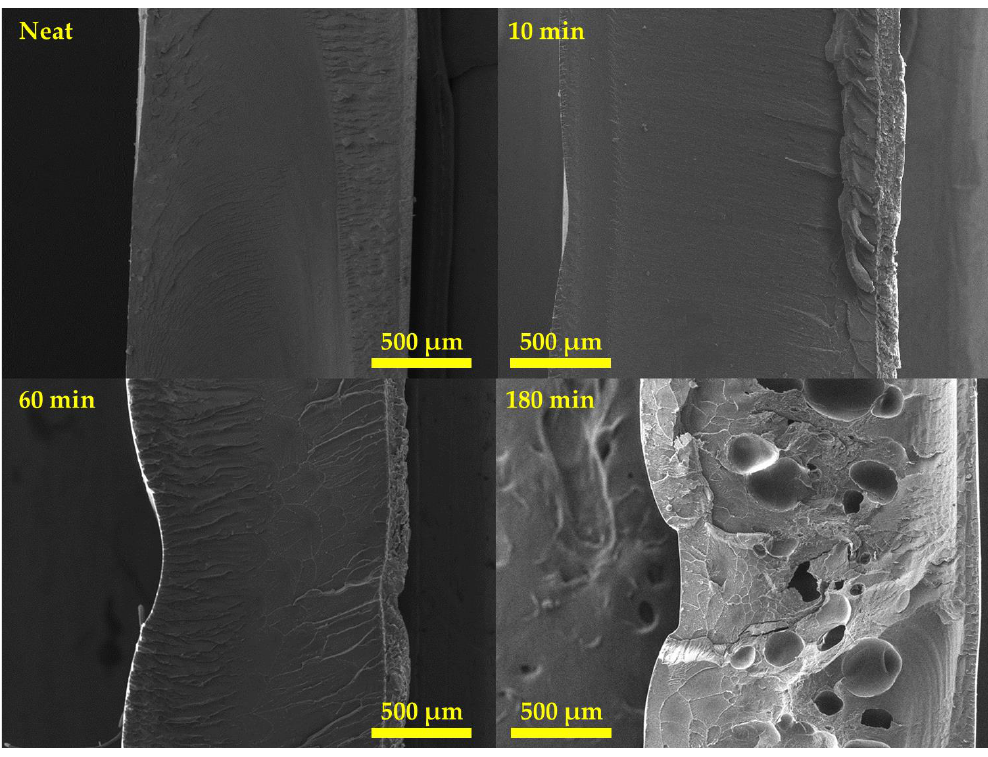
Figure 8. SEM images of specimen as a function of saturation time (×50).